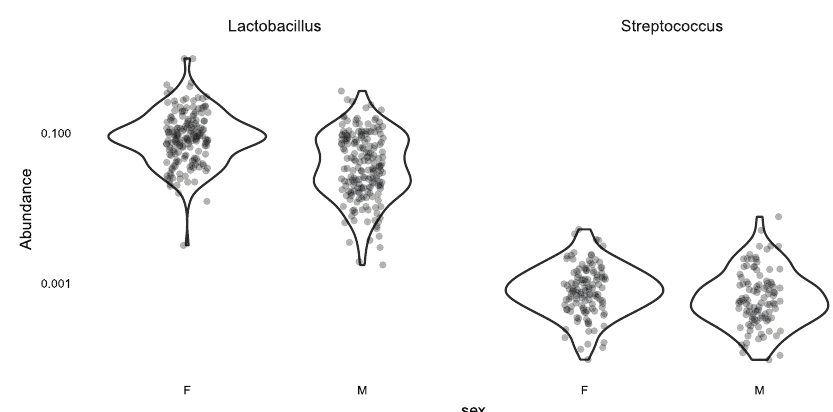
Figure 6. Violin plot of the relative abundances of Lactobacillales taxonomic Order, grouped by host sex and genera. Here it is clear that the apparent biomodal distribution of Lactobacillales on the previous plot was the result of a mixture of two different genera, with the typical Lactobacillus relative abundance much larger than Streptococcus .